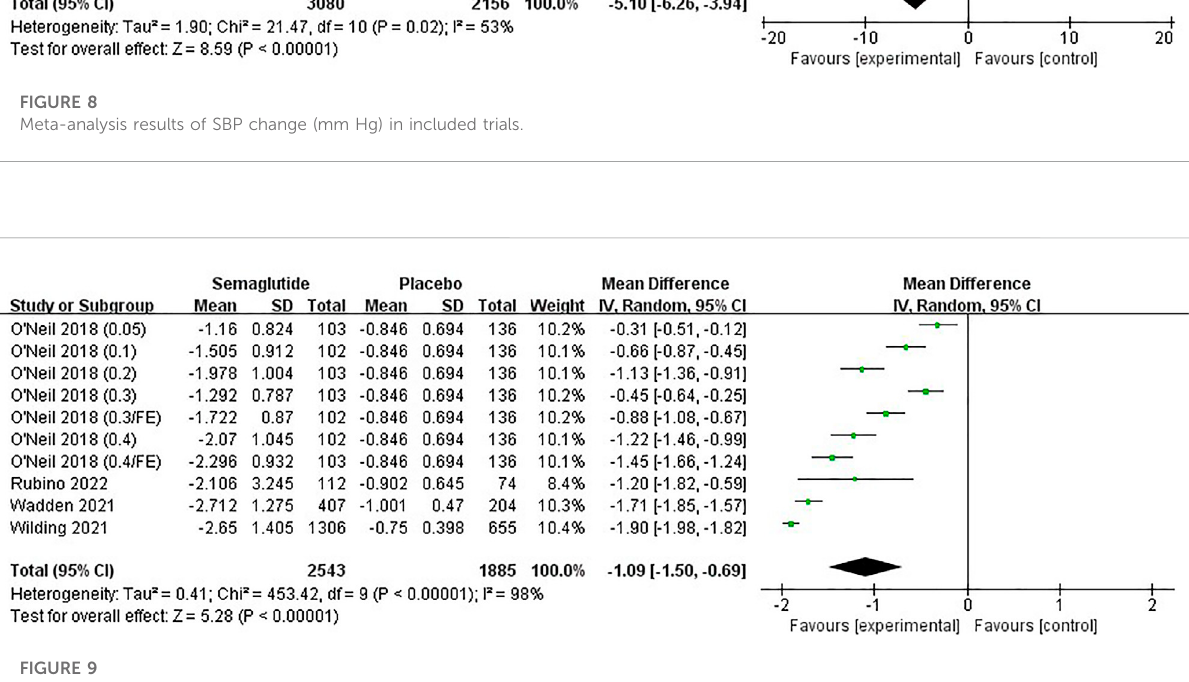
FIGURE 9 Meta-analysis results of CRP change (mg/L) in included